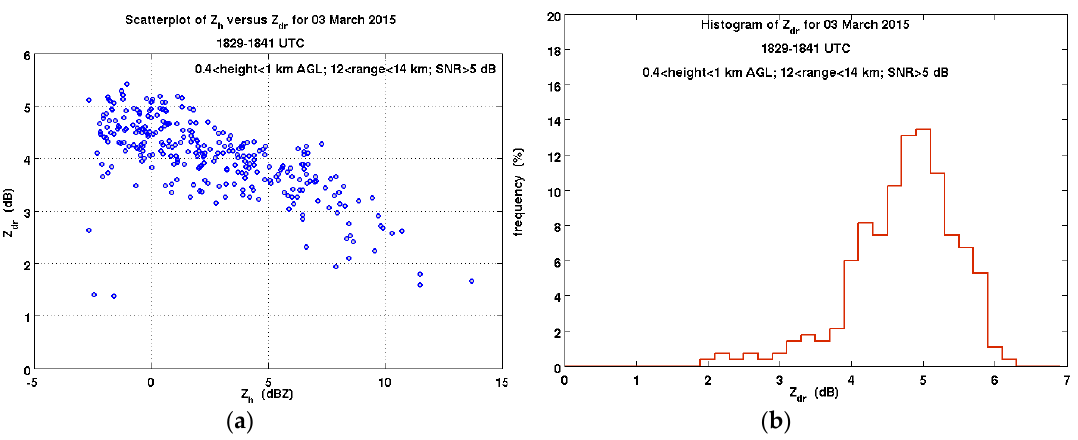
Figure 35. ( a ) Z h vs. Z dr scatterplot and ( b ) Z dr histogram for 18:29–18:41 UTC on 3 March 2015 in the immediate Easton area.